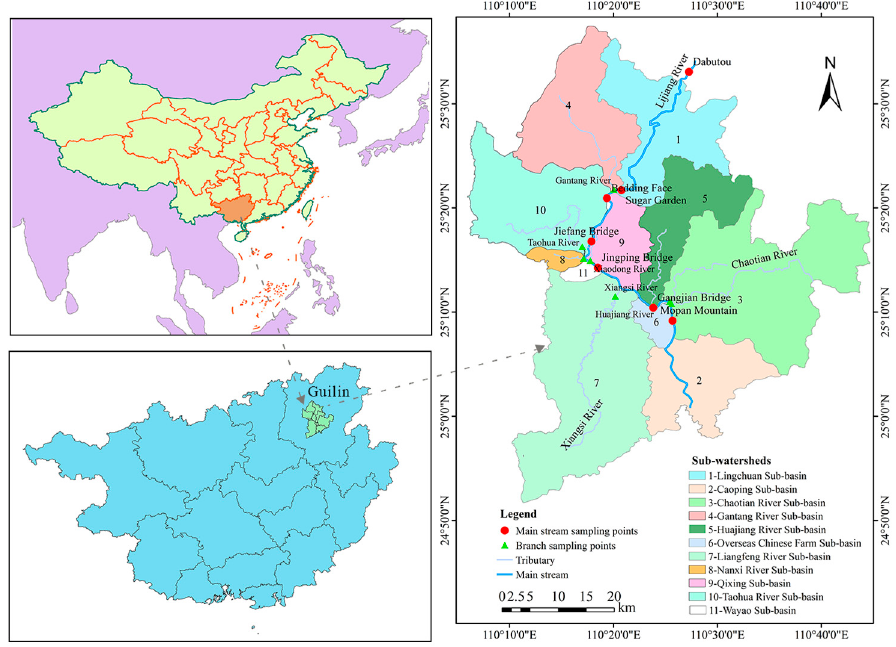
Figure 2. Research area and